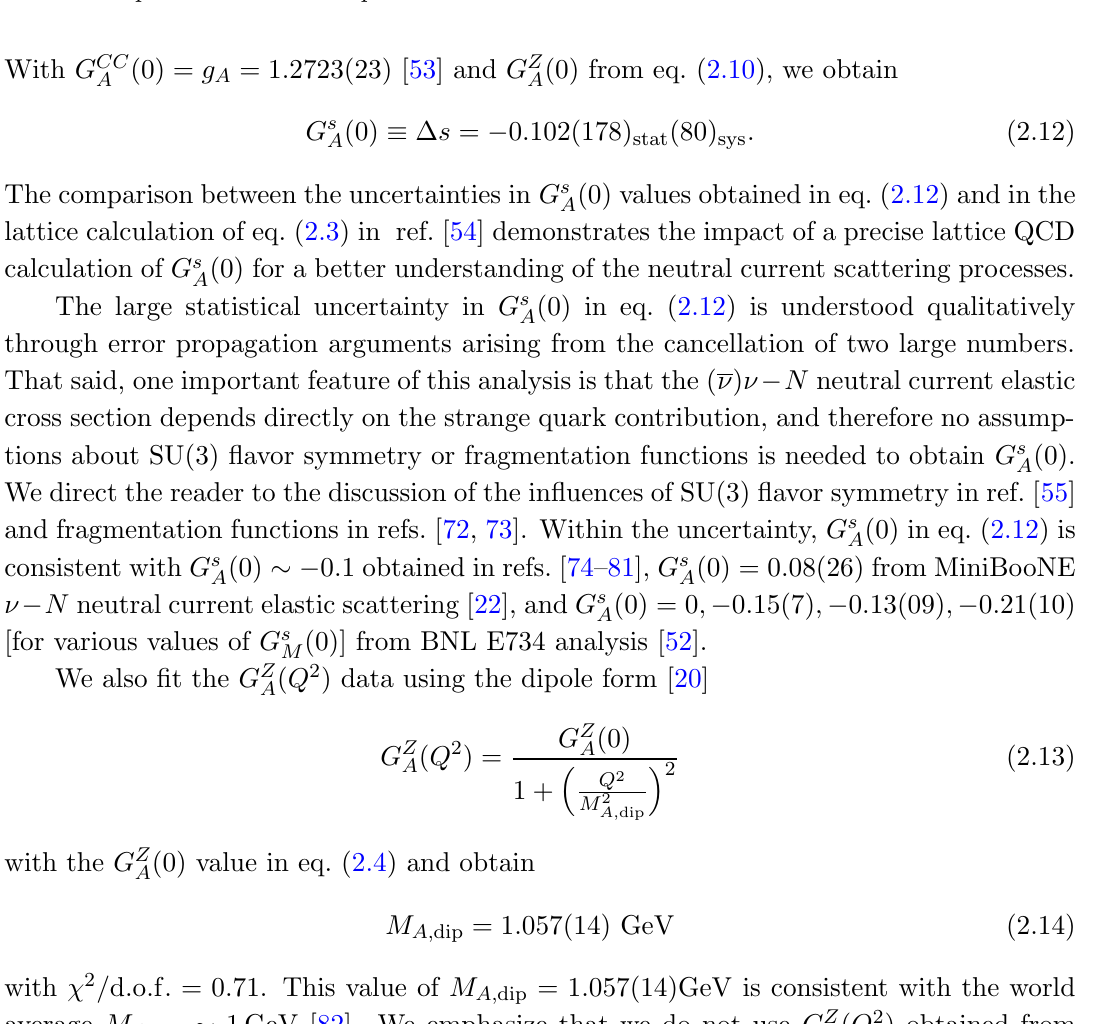
Table 1 . Parameters of z -expansion (cid:12)t to eq. ( 2.9) for G Z z -expansion (cid:12)t parameters with and without the lattice QCD input of strange quark contribution to nucleon spin is shown for